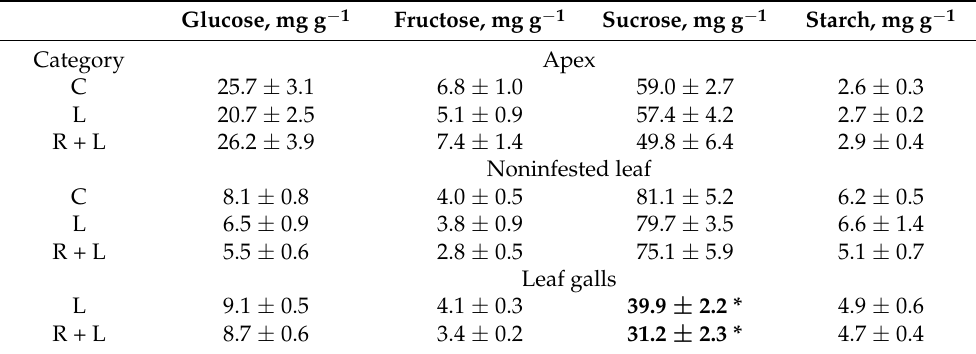
Table 1. Glucose, fructose, sucrose and starch measured in aboveground organs sampled from control (C), leaf (L), and both root and leaf infested (R + L) plants 56 days after inoculation. * (and bold) indicates significant difference between L and R + L group (Student’s t -test).